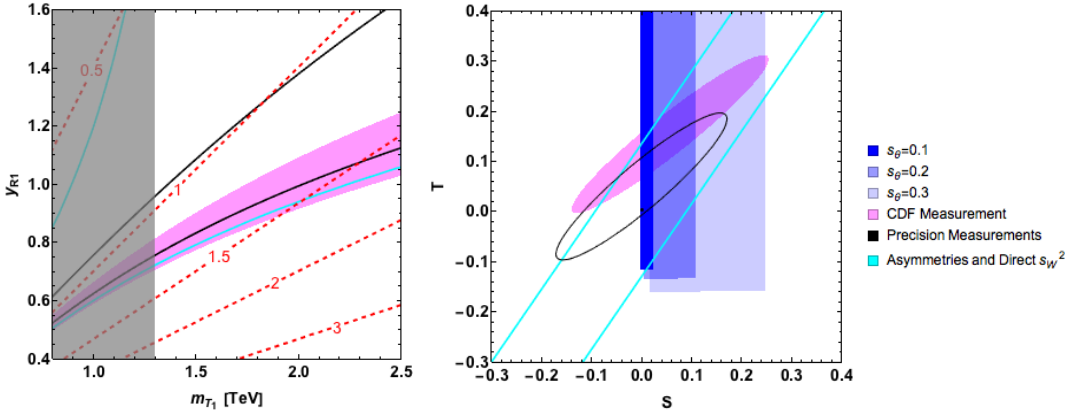
Figure 2 . Comparison of the new CDF measurement of the W mass (magenta band) to the param- eter space of the SU (4) Q / Sp (4) Q Composite Higgs model, including only the S and T contributions from the fermion resonance singlet. Between the black lines or in the ellipse the precision mea- surements are fulfilled, while the cyan lines indicate the bound stemming from asymmetries and direct s 2 determination. All bounds are shown at 2 σ confidence level. Left panel: the bands in W the m T - y R 1 parameter space for s θ = 0 . 2 , m V,A = 3 TeV, g = 3 and r = 0 . 8 , where the dashed red e 1 & 1 . 3 TeV lines represent the values of y L 1 . The gray region is excluded by the lower bound on m T 1 from CMS and ATLAS [43–46]. Right panel: the bands in the S - T parameter space, where the blue regions represent the parameter space of the model for s θ = 0 . 1 , 0 . 2 , 0 . 3 . We have scaned over g ≥ 3 , e 0 . 5 ≤ y R 1 ≤ 5 , m V,A ≥ 3 TeV and 0 ≤ r ≤ 1 , while m T ≥ 1 . 3 TeV from CMS and ATLAS 1